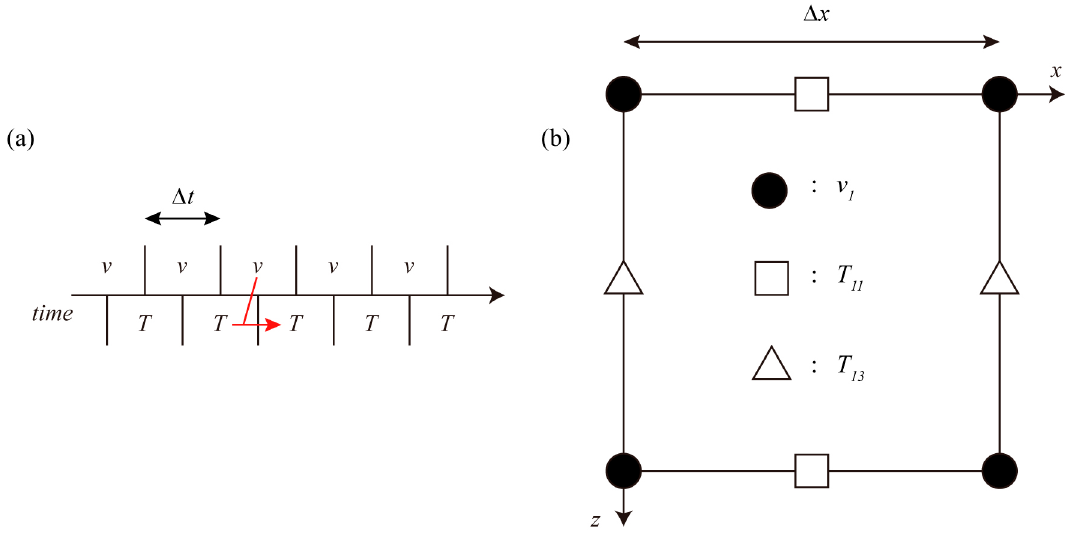
Figure A1. Schematic diagram of the staggered-grid finite-difference method. ( a ) Staggered grids in time; ( b ) staggered grids in space, v is the velocity and T is the stress, subscript 1 and 3 refer to the X and Z direction of space.